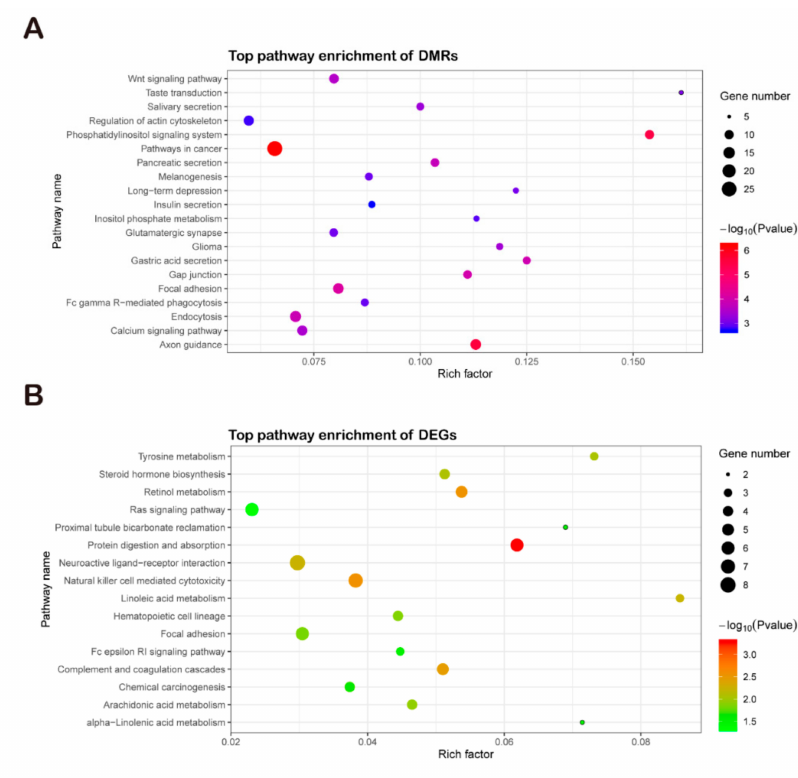
Figure 7. Comparison of KEGG analysis of DMRs and DEGs. ( A ) KEGG analysis of DMRs. ( B ) KEGG analysisofDEGs. KEGG,EncyclopediaofGenesandGenomesenrichmentanalysis; DMRs, di ff erentially methylated regions; DEGs, di ff erentially expressed